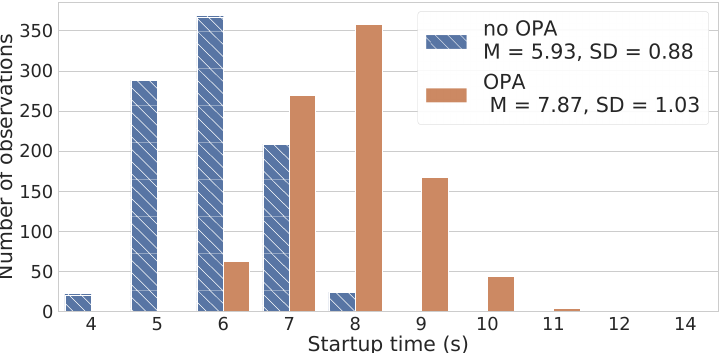
Figure 5. Distribution of startup time in deployments with/without OPA. Request time